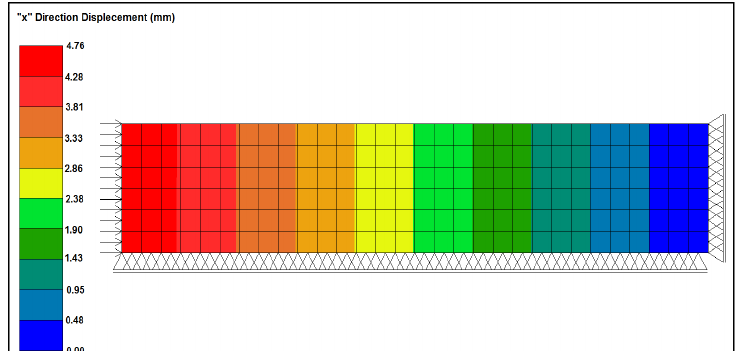
Figure 11. Field of creep longitudinal displacements: Day 379 - Case 11.